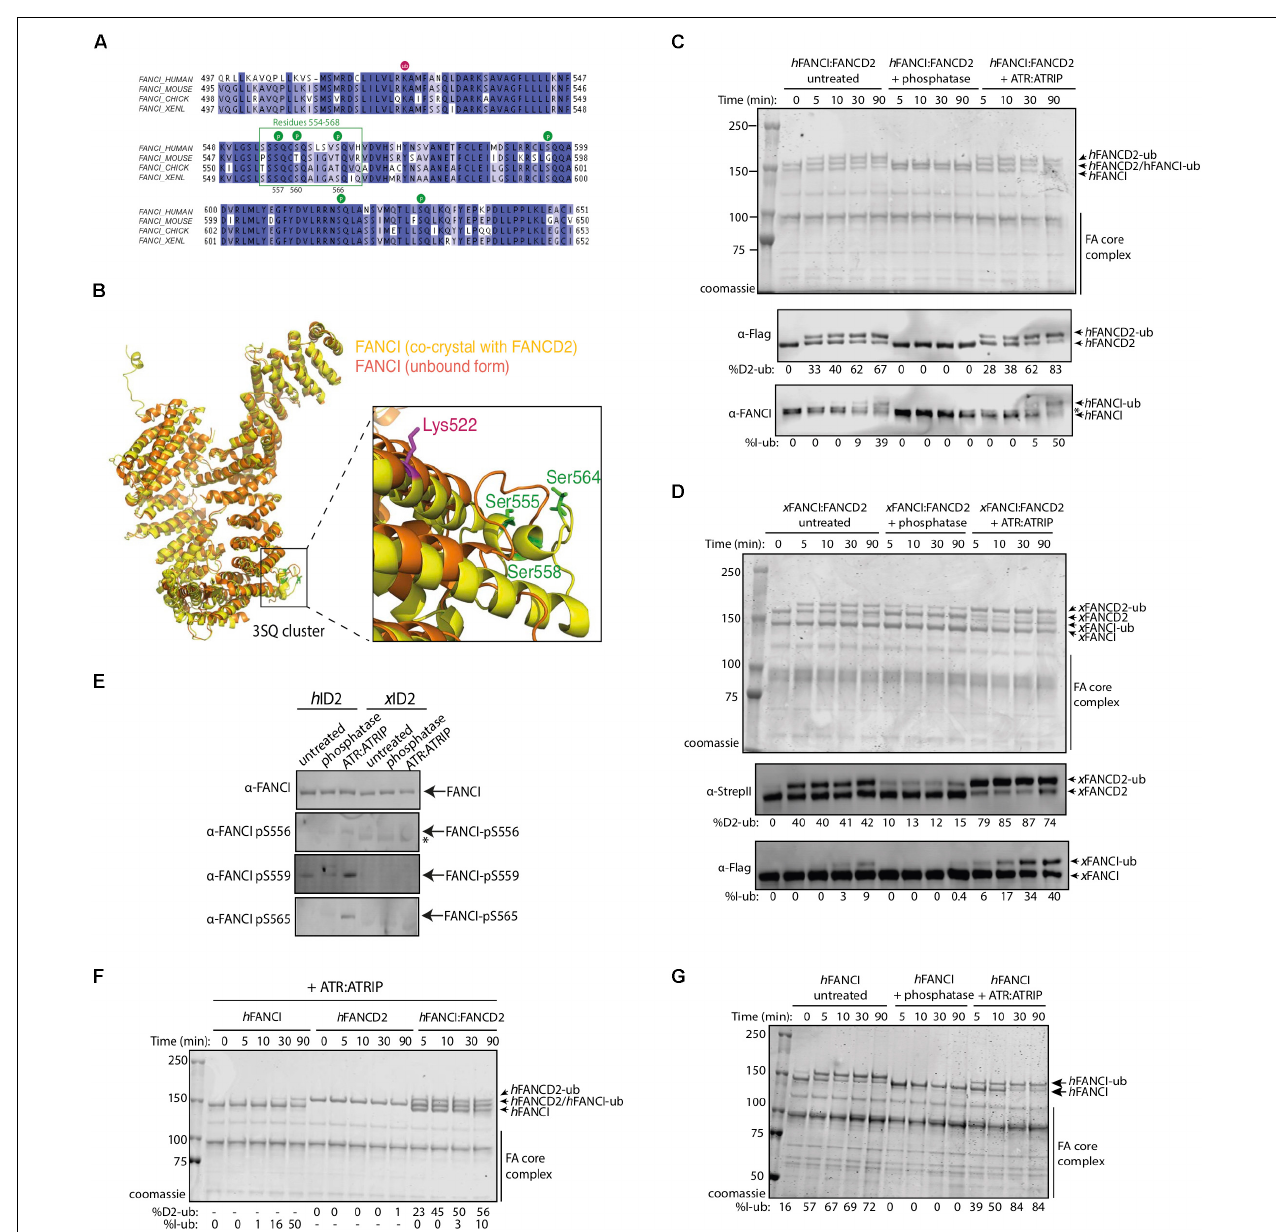
FIGURE 1 | FANCI phosphorylation at serines 557, 560, and 566 are required for FANCI:FANCD2 monoubiquitination. (A) Sequence alignment of the FANCI SQ/TQ loop across different species including human, mouse, chicken and Xenopus laevis (frog). Phosphorylation sites are indicated and residues 554–569 accounting for FANCI SQ/TQ loop are boxed in green. (B) Superposition of FANCI unbound (orange, PDB ID 3Z51) and FANCD2-bound (yellow, PDB ID 3S4W) structures revealed little conformational differences except in the clustered SQ/TQ sites near FANCI monoubiquitination site, Lysine 522. (C) Coomassie stained SDS-PAGE gel showing in vitro ubiquitination assays of untreated, Lambda phosphatase or ATR-ATRIP kinase treated human FANCI:FANCD2 (hID2) and (D) Coomassie stained SDS-PAGE gel showing in vitro ubiquitination assays of untreated, Lambda phosphatase or ATR-ATRIP kinase treated Xenopus FANCI:FANCD2 (xID2) complex. (E) Western blot showing that human FANCI phosphosites 556, 559, and 565 are phosphorylated in ATR-ATRIP treated ID2. (F) Coomassie stained SDS-PAGE gel showing the ubiquitination time course of ATR:ATRIP treated isolated human FANCI, FANCD2, or FANCI:FANCD2 complex. (G) Coomassie stained SDS-PAGE gel showing the ubiquitination time course of untreated, phosphatase or ATR:ATRIP treated human FANCI. All data are representative of three experiments.